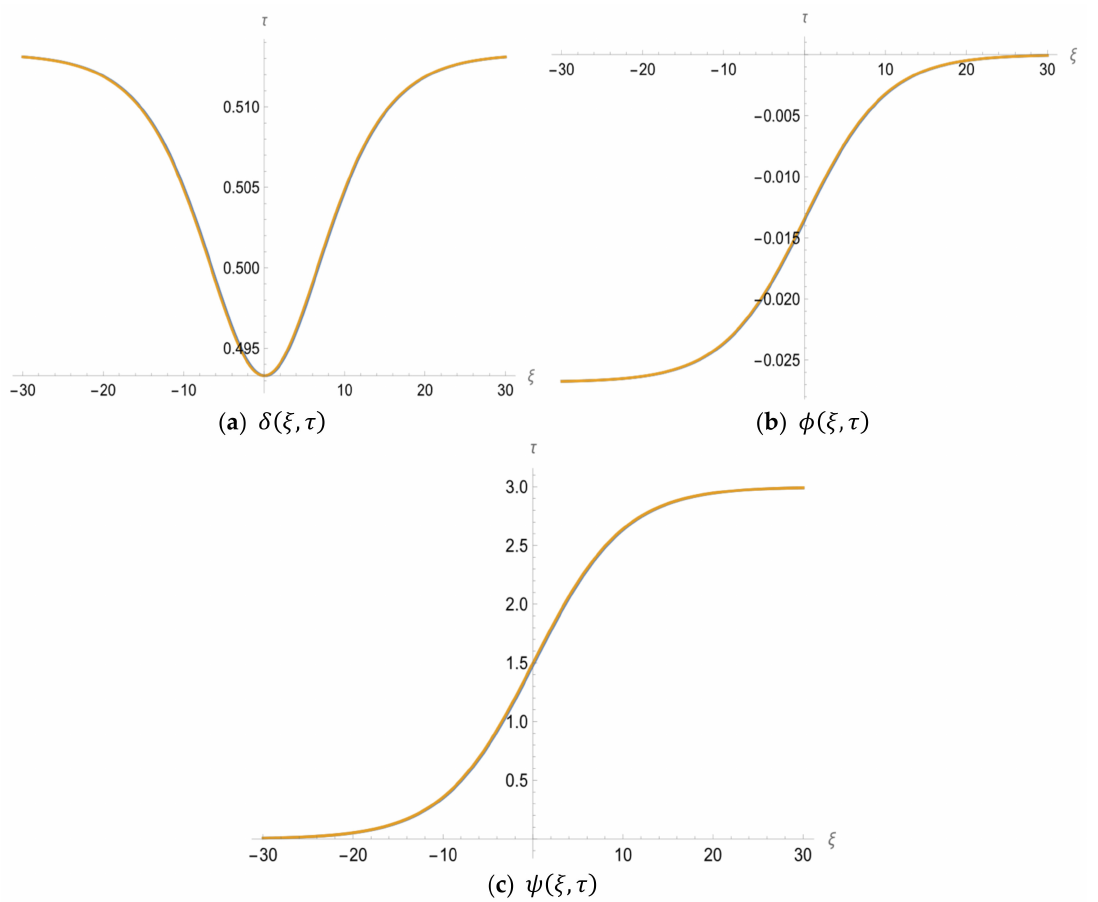
Figure 3. The graph of the 5th LRPSM solutions δ ( ξ , τ ) , φ ( ξ , τ ) , and ψ ( ξ , τ ) for HSC–KdV equations at τ = 0.1, τ = 1, τ = 0.1, τ = 3, ξ ∈ [ − 30,30 ] , and α =